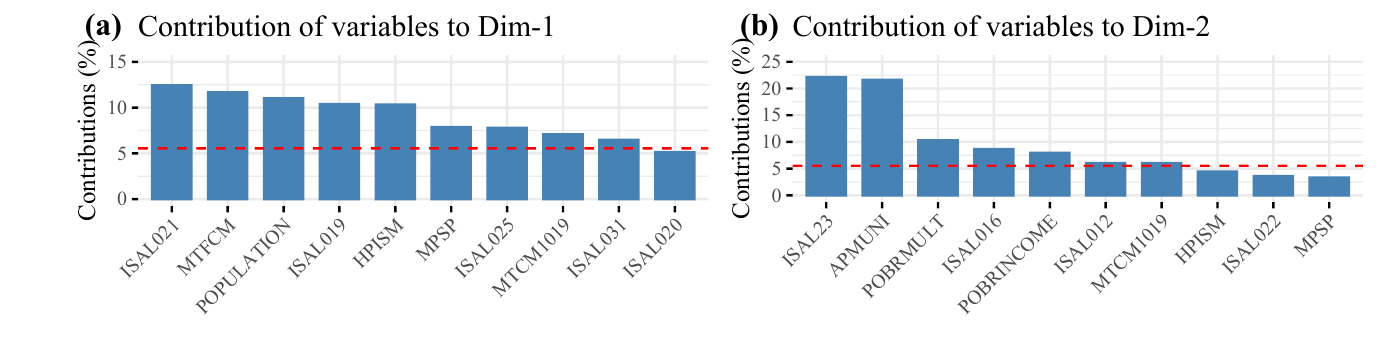
Figure 3. Contribution of variables to: ( a ) Dim. 1, ( b ) Dim.